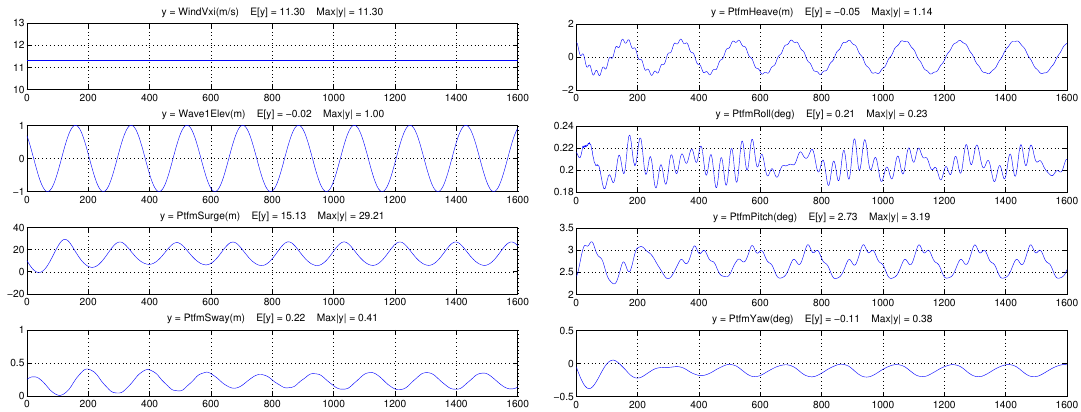
Figure 14. Time series of the integrated system for a unit-amplitude wave at a surge natural frequency of 0.0057 Hz (for rated wind velocity, V rated = 11.3 m/s).